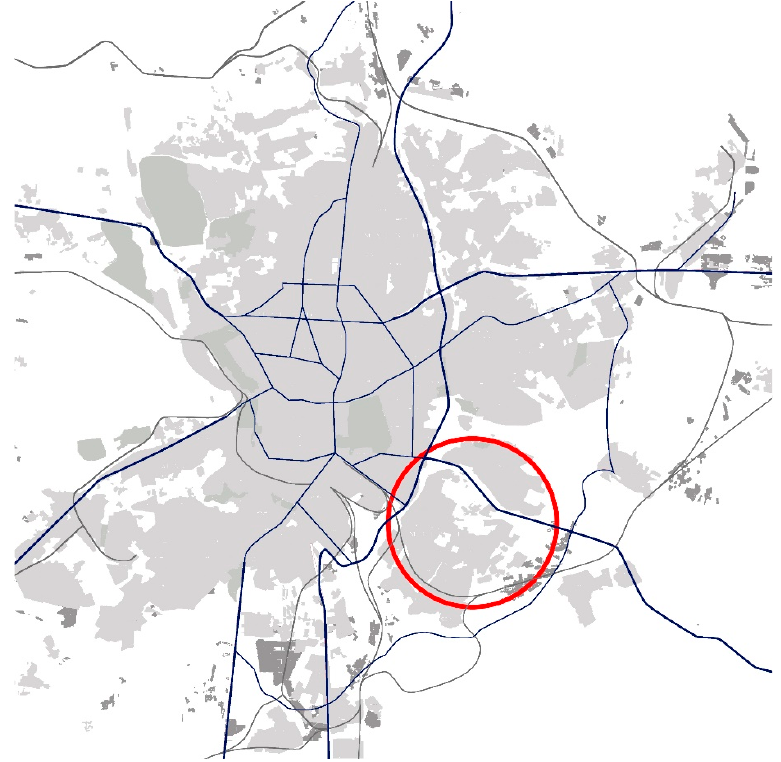
Figure 1. Madrid plan, 1978. Palomeras area surrounded by a red circle. Created by author.